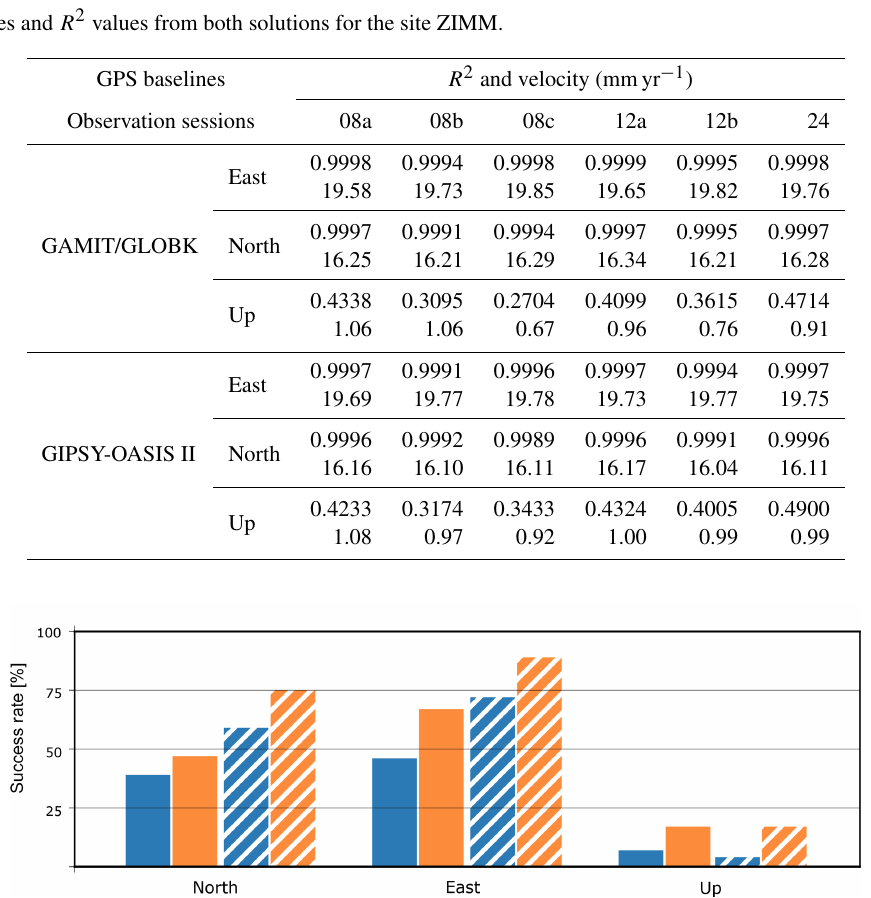
Figure 4. Success rates of 8h and 12h sessions. The velocity estimation from short sessions is compared with 24h results for each GPS component. Blue bars are for the 8h and orange bars are for the 12h sessions. Dashed patterns illustrate PPP estimates, whereas no patterns are for the relative